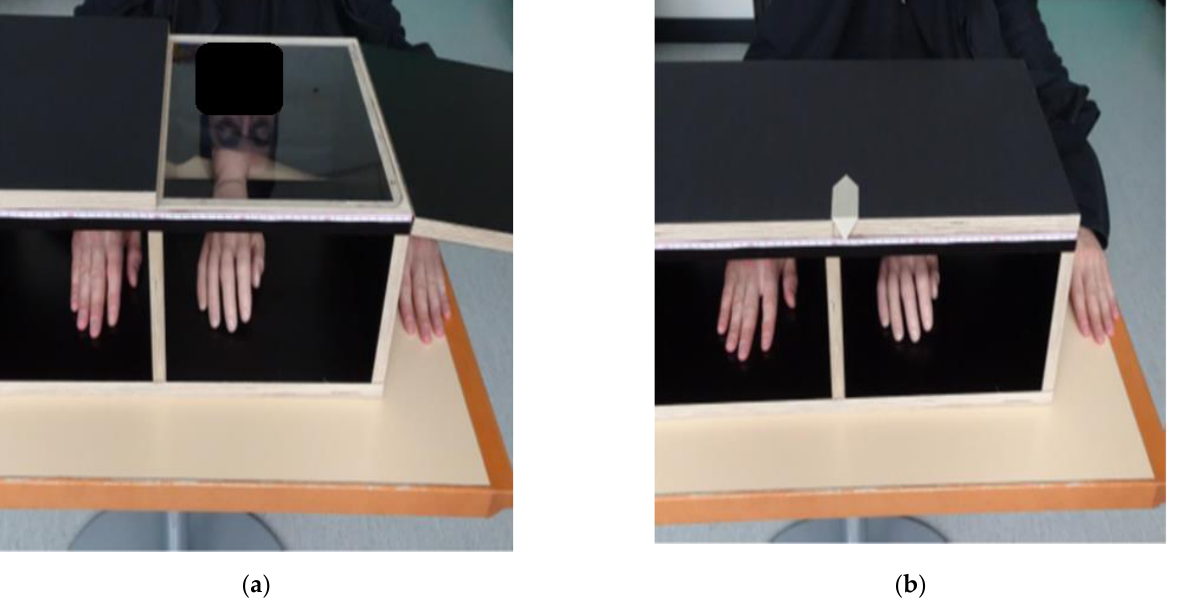
Figure 1. Rubber hand illusion experimental setup. ( a ) Stimulation phase: during the stroking with a paintbrush, the participant sees a rubber hand while their real hand (here, the right hand) is hidden. ( b ) Measurement condition. Both the real and the rubber hands are hidden. The participant indicates where he feels the index finger of his (in this case, right) hand by instructing the experimenter to move the cursor to the right or to the left.